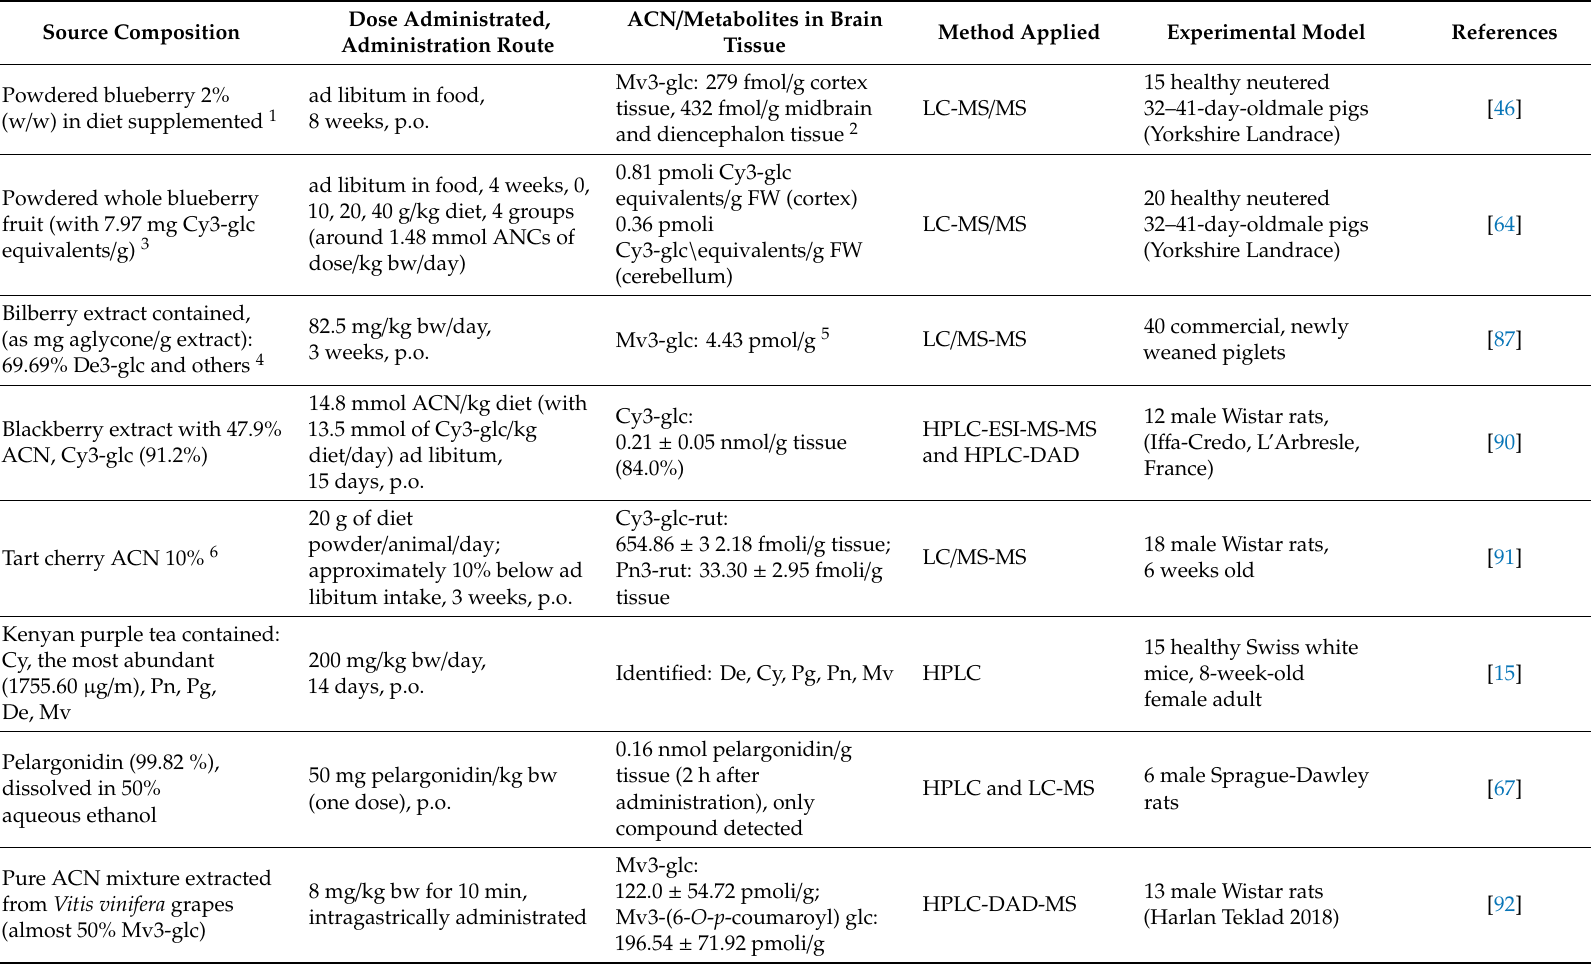
Table 3. The in vivo studies reporting anthocyanins (ACN) in brain tissue (parent compounds or metabolites)